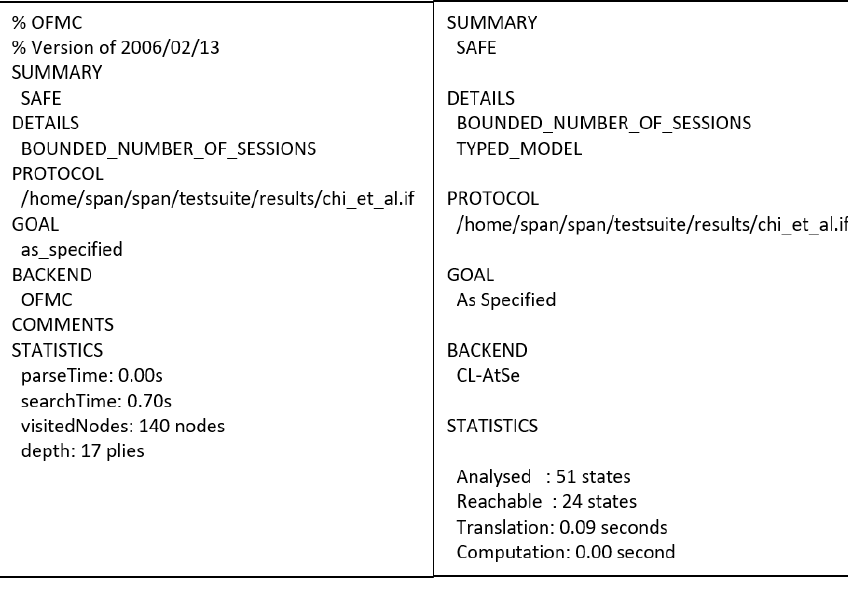
Figure 9. AVISPA result of Chi et al.’s protocol.